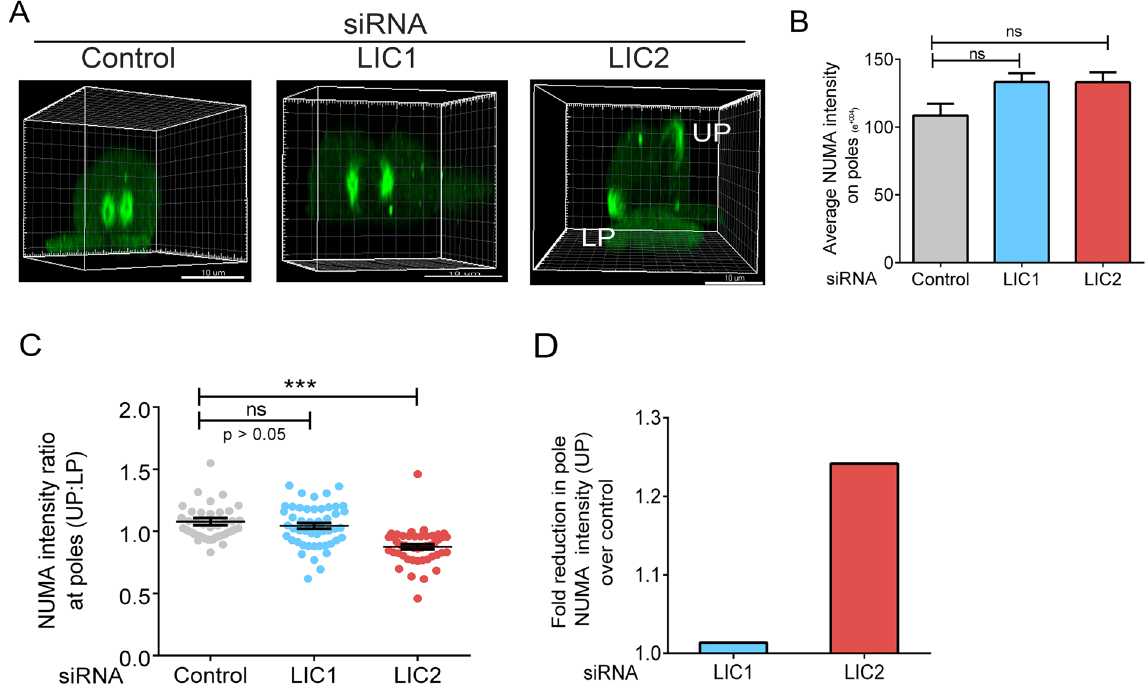
Figure 4. LIC2 transports NuMA to the spindle pole during mitosis. ( A ) Representative 3D reconstructions from confocal immunofluorescence images showing spindle poles in mitotic HeLa cells. LP = lower pole, UP = upper pole in LIC2 depleted (mis-oriented) cells. ( B ) Average NuMA intensity at poles from quantification using 3-dimensional regions of interest drawn around the centrosomes. Error bars are mean + / − SEM from 3 independent experiments, at least 20 metaphase cells per experiment. ( C ) Ratio of fluorescence intensities (UP/LP) in metaphase cells–54 cells (control), 57 cells (LIC1 depleted) and 55 cells (LIC2 depleted) over a total of 3 experiments. Error bars are mean + / − SEM from 3 independent experiments. ( D ) Fold reduction in average NuMA levels at the upper pole upon LIC2 depletion in comparison to control cells from the data used for